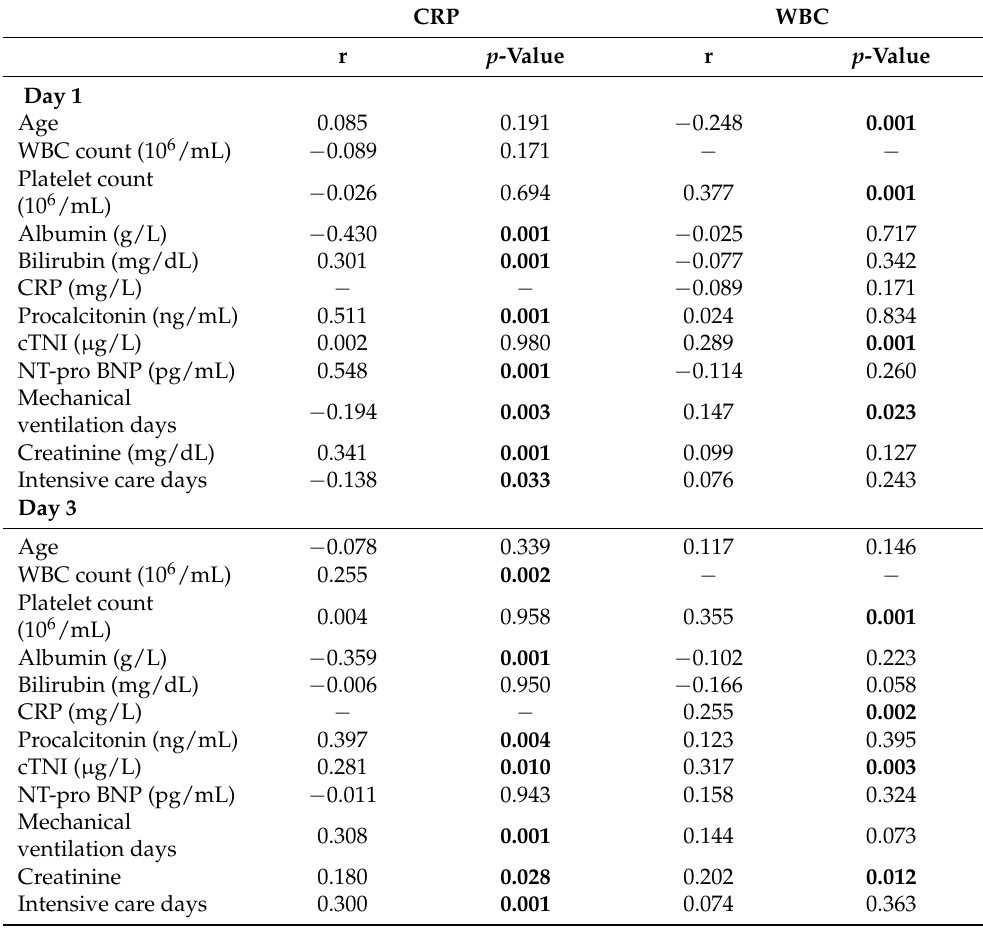
Table 3. Univariate correlations of the CRP and WBC with laboratory and clinical parameters in all patients on day 1 and day